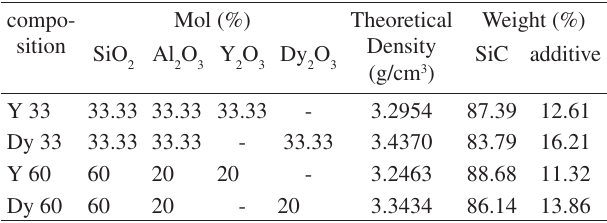
Table 1. Composition